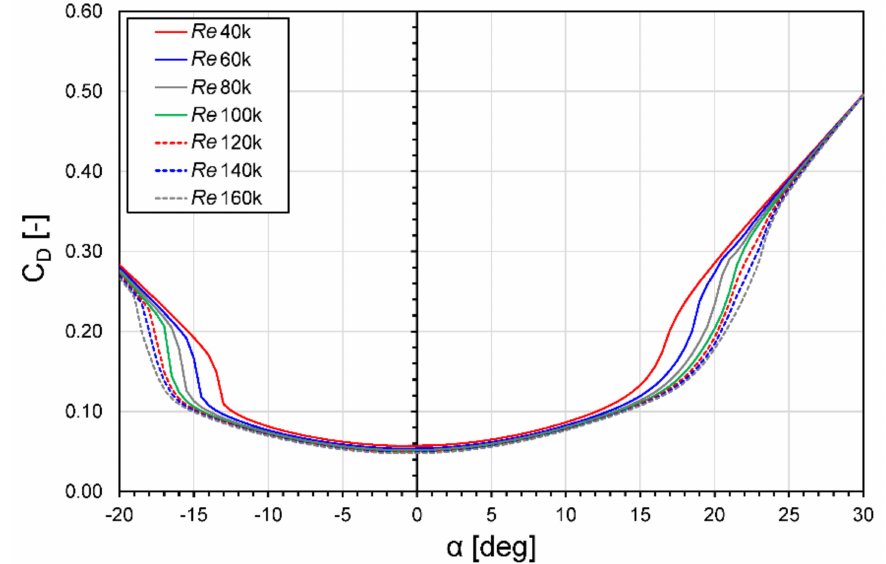
Figure 11. Drag polars for di ff erent Reynolds values with a high turbulence flow.